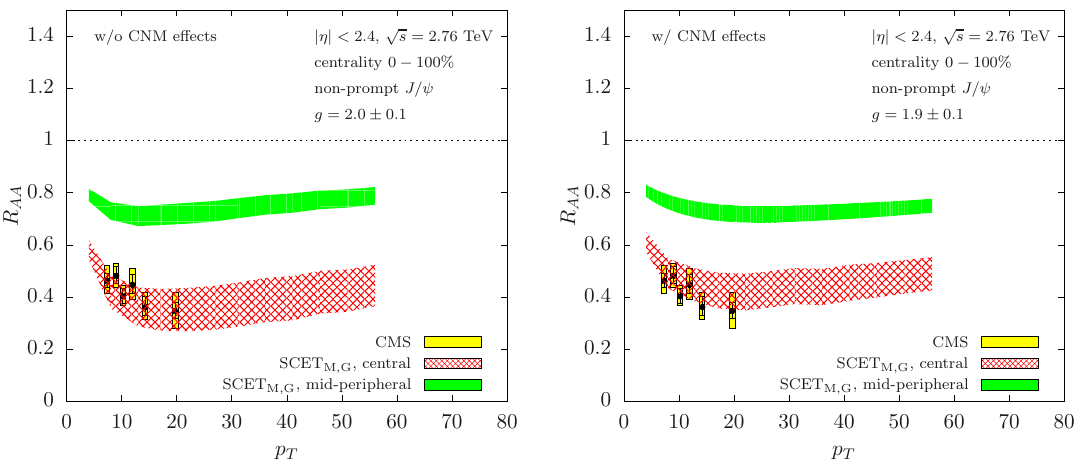
Figure 14 . Nuclear modi(cid:12)cation factor R AA for non-prompt J= production which originate from p B -meson decays. The CMS data [8] was taken at s NN = 2 : 76 TeV for j (cid:17) j < 2 : 4 and 0 (cid:0) 100% centrality. For comparison, we present our B -meson results for central (0 (cid:0) 10% centrality, hatched red band) and mid-peripheral (30 (cid:0) 50% centrality, green band) collisions with the B ! J= kinematic p T downshift. Again, we present our theoretical results without CNM e(cid:11)ects (left, g = 2 : 0 (cid:6) 0 : 1) and with CNM e(cid:11)ects (right, g = 1 : 9 (cid:6) 0 :